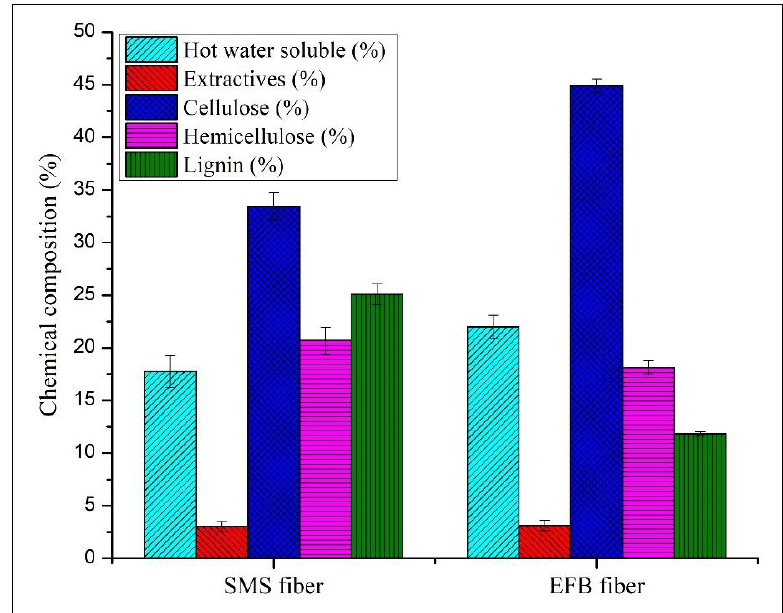
Figure 5. The average percentage of chemical composition (hot water-soluble content, extractives, cellulose, hemicellulose, and lignin) for the SMS and EFB fibers using the Soxhlet extraction method.